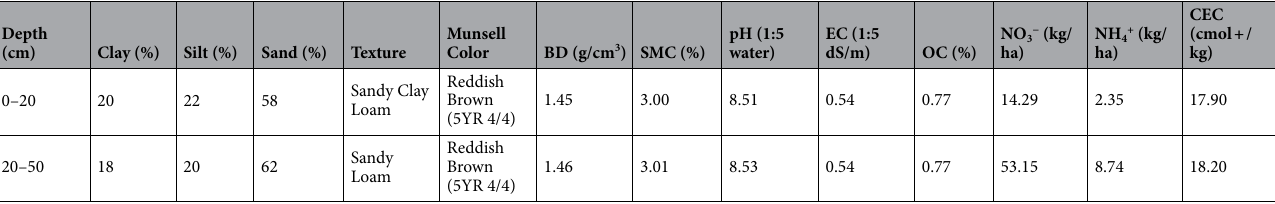
Table 1. Soil physical and chemical properties of the Rhamna